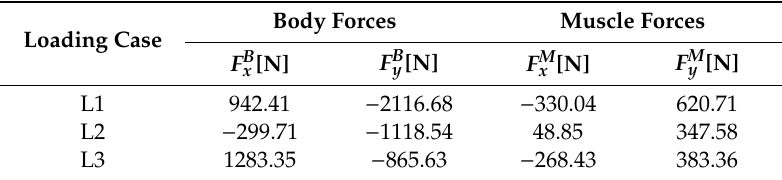
Figure 2. Boundary conditions and applied loads of the newly proposed model. Table 1. Force components [10].